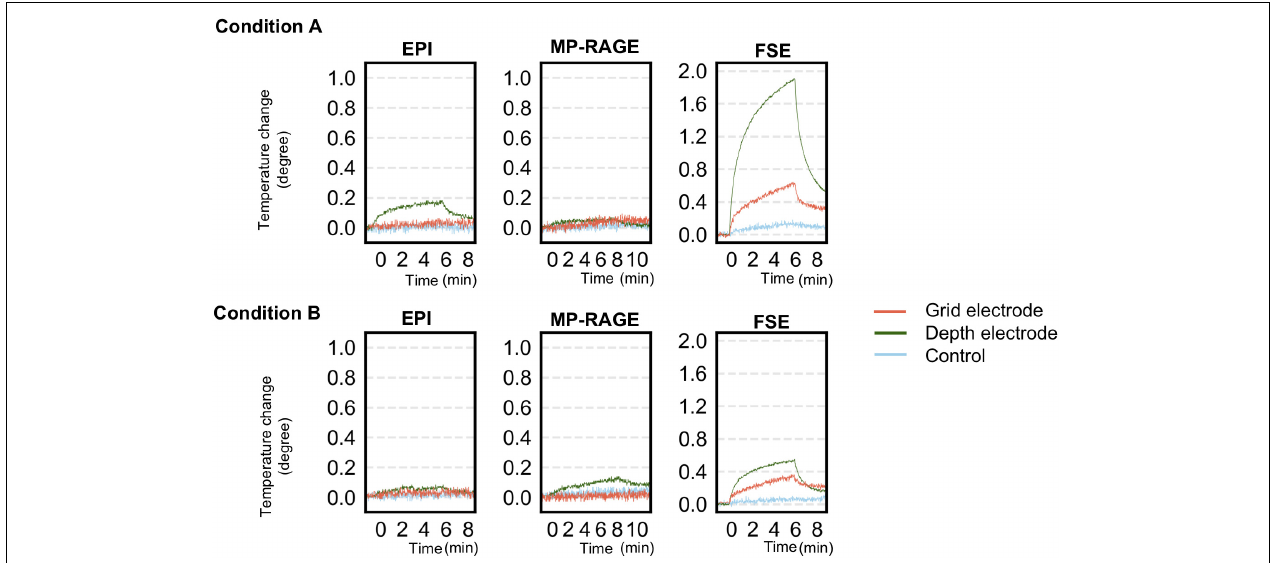
FIGURE 6 | Temperature changes observed during a scan of each sequence for simultaneous acquisition of icEEG and fMRI (EPI, MP-RAGE), and a high-SAR sequence (FSE) as control in experiment A. The upper panel shows the changes at each electrode when oriented perpendicularly to B 0 (configuration A1). The lower panel shows the changes at each electrode when oriented parallel to B 0 (configuration A2). The temperature change was generally larger in configuration A1 except for MP-RAGE. SAR, specific absorption rate; EPI, echo planar imaging; FSE, fast spin echo; MP-RAGE, magnetization-prepared rapid